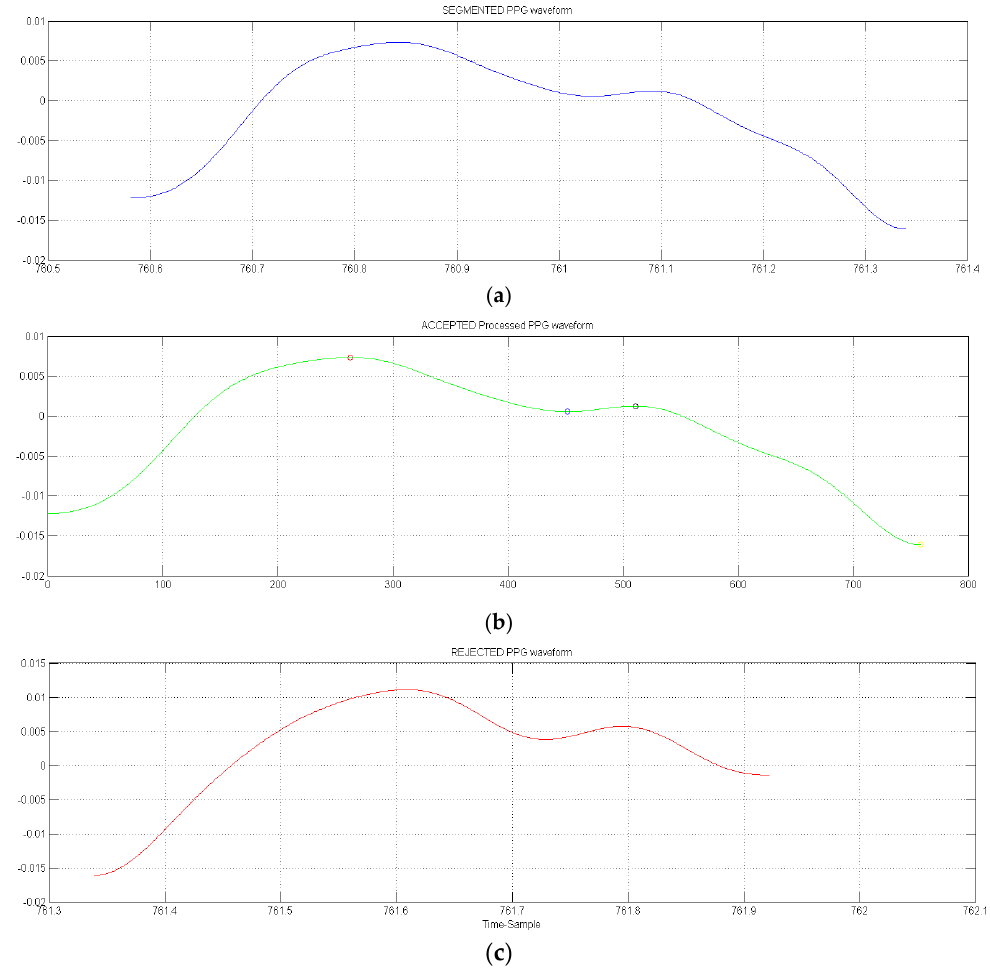
Figure 21. Representative results of accepted (blue PPG in ( a )) vs rejected (red PPG in ( c )) segmented PPG waveform. ( b ) shows accepted PPG waveform in which the described FD analysis is performed in order to detect the maximum (systolic peak), dichrotic and diastolic points (green waveform with highlighted points as circle).